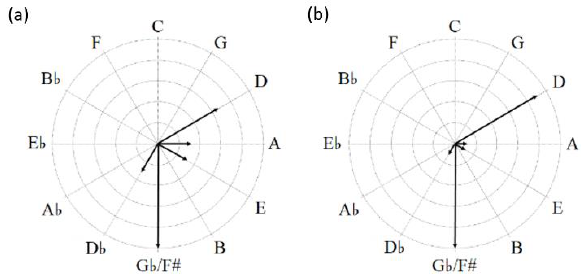
Figure 2. The analyzed fragment of a sample music piece. The signatures of fifths representing the fragment of the music piece shown in Figure 1: ( a ) obtained for the multiplicities of occurrences of individual pitch-classes; ( b ) obtained for the aggregate durations of individual pitch-classes.